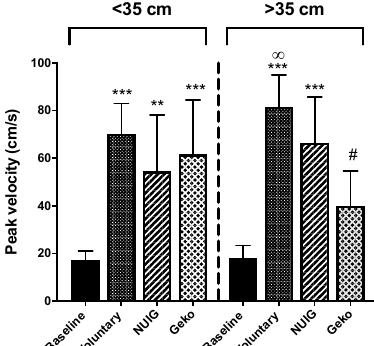
Figure 5. Effect of calf muscle circumference size on peak velocity. Voluntarily contraction ( n = 10), Geko ( n = 3–5), and NUIG ( n = 4–5) showed a significant increase on PV in comparison to baseline ( n = 10) for calf muscle circumference of < 35 cm. For calf muscle of > 35 cm, only voluntarily contraction and NUIG showed a significant change in PV when compared to baseline. (** P < 0.001, *** P < 0.0001 versus baseline, # P < 0.05 versus. NUIG, ∞ P < 0.001 versus Geko). Data shown as ±